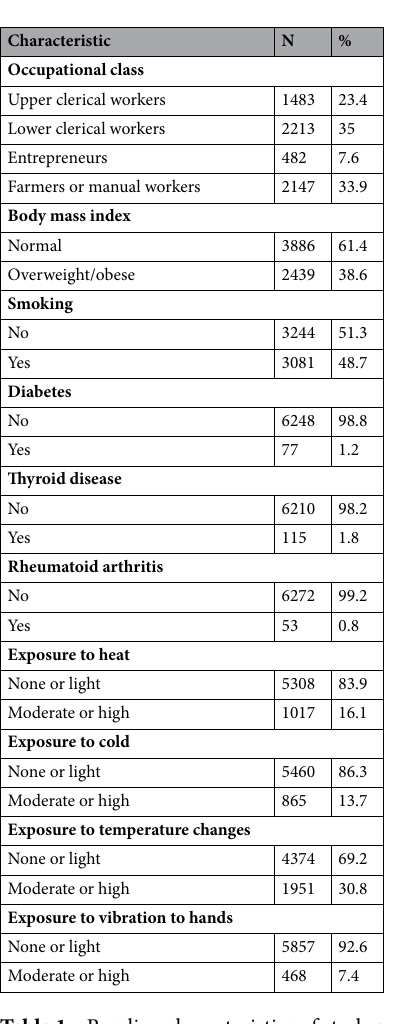
Table 1. Baseline characteristics of study